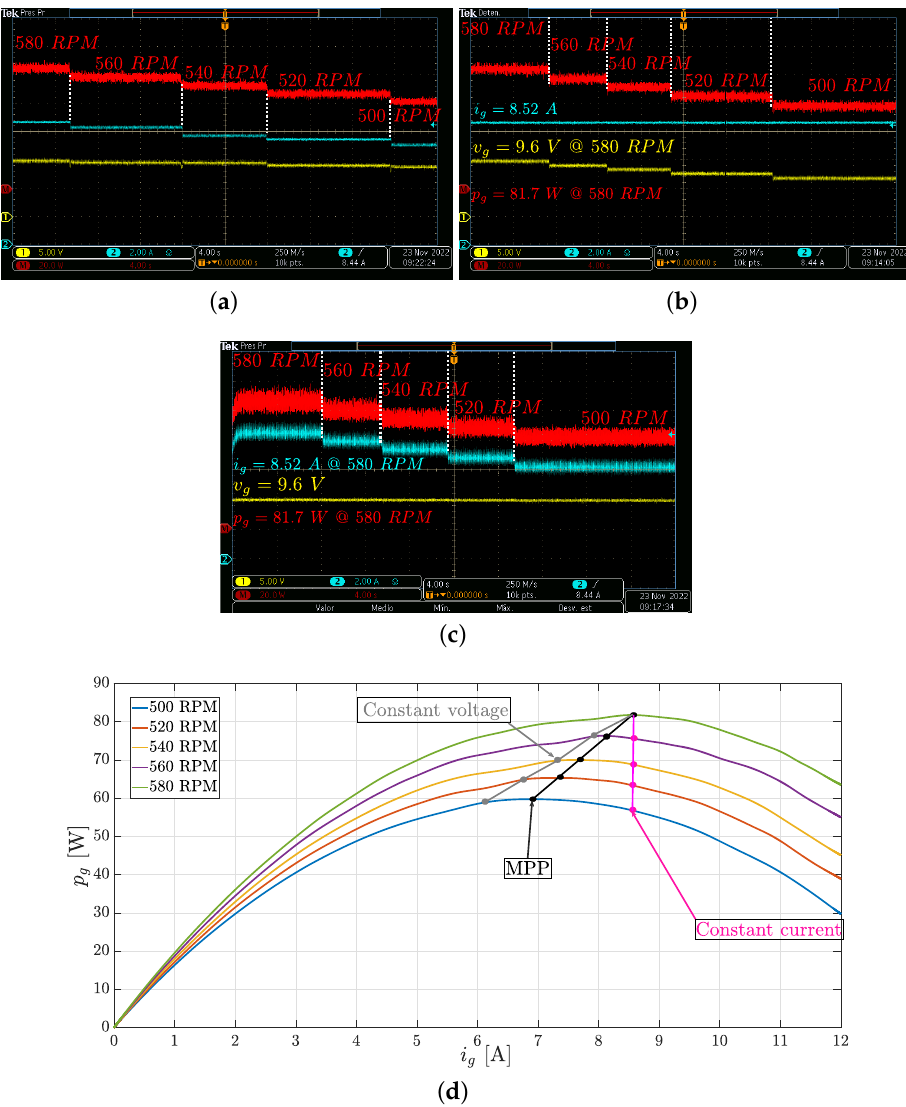
Figure 4. Wind-turbine generation system at several operating points. ( a ) WTGS operating at MPP for several speeds. ( b ) WTGS operating whit constant current for several speeds. ( c ) WTGS operating whit constant voltage for several speeds. ( d ) Operating point for constant current, constant voltage and